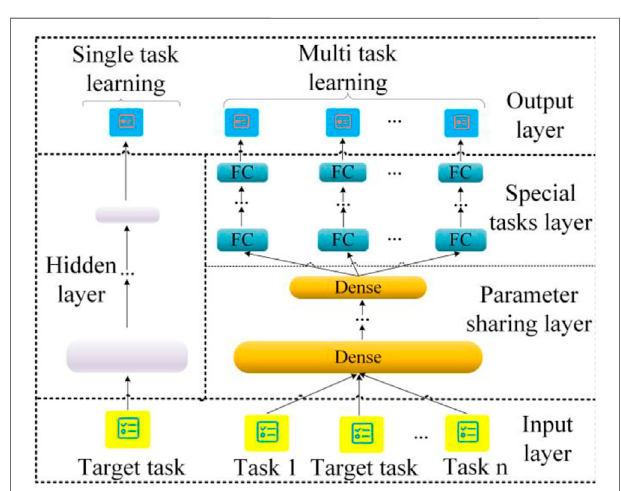
Frontiers in Materials |